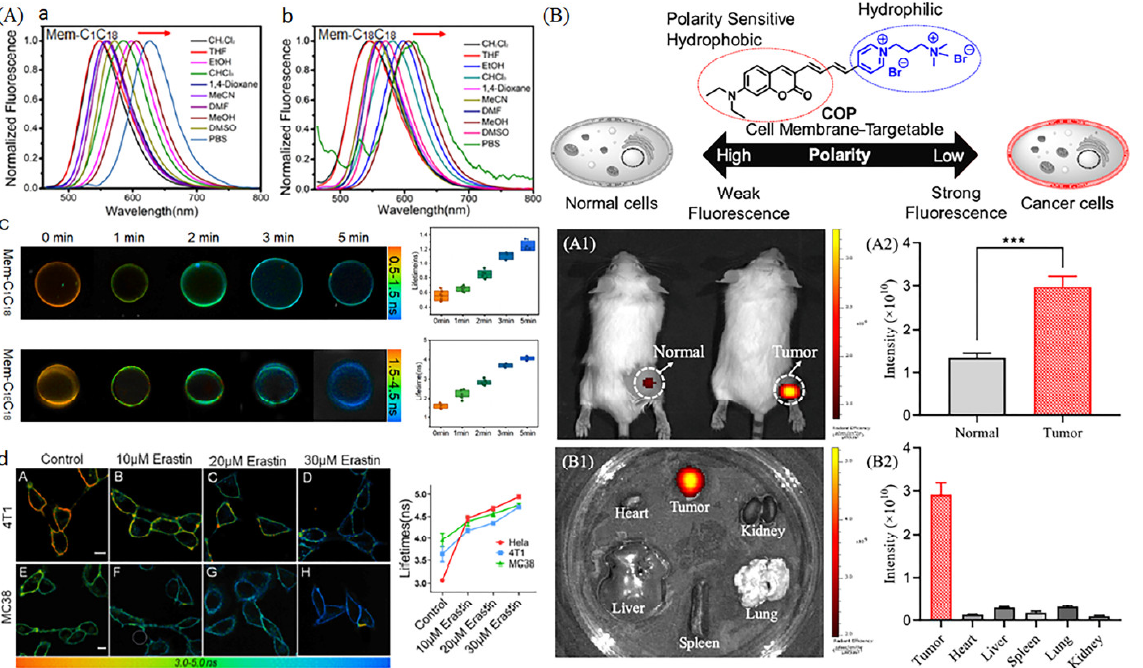
Figure 21. ( A ) Fluorescence spectra of Mem-C1C18 ( a ) and Mem-C18C18 ( b ) in several different polarity solvents, and the GUVs pictures ( c ) with a certain period of lipid peroxidation. ( d ) Pictures of 4T1 and MC38 cells incubated with Erastin. Reproduced from 106 with permission of the Ameri- can Chemical Society, copyright 2022. ( B ) Mechanisms of probe COP and their applications. ( A1 ) Fluorescence pictures of normal and tumor rats stained with COP and the corresponding fluores- cence intensity ( A2 ). ( B1 ) Fluorescence organ pictures of tumor rats stained with COP and the cor- responding fluores-cence intensity ( B2 ). *** p (statistical significance) = 0.0004. Reproduced from [105] with permission of the American Chemical Society, copyright 2022.